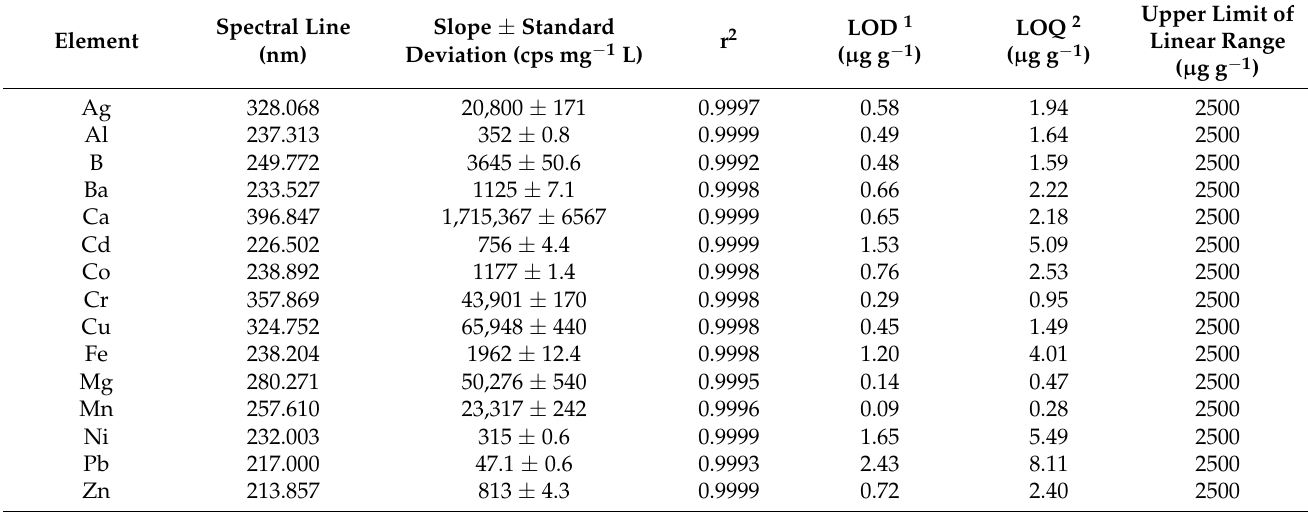
Table 2. Analytical performance characteristics of the developed ICP-AES